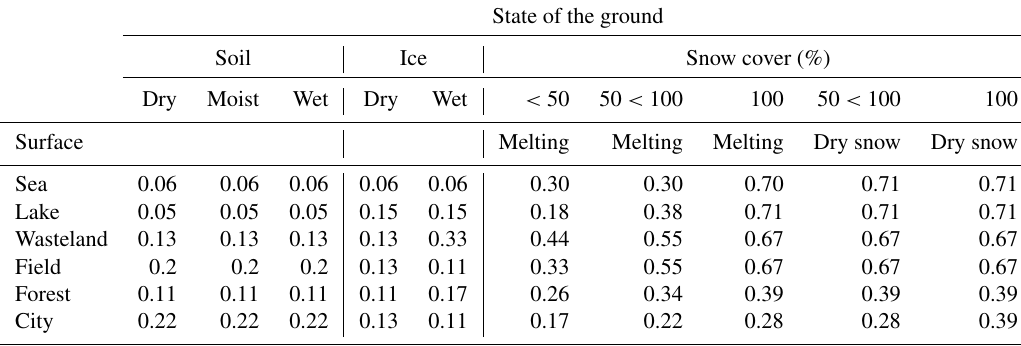
Table B1. Lookup table for surface albedo ( r ) based on surface type and state of the ground.